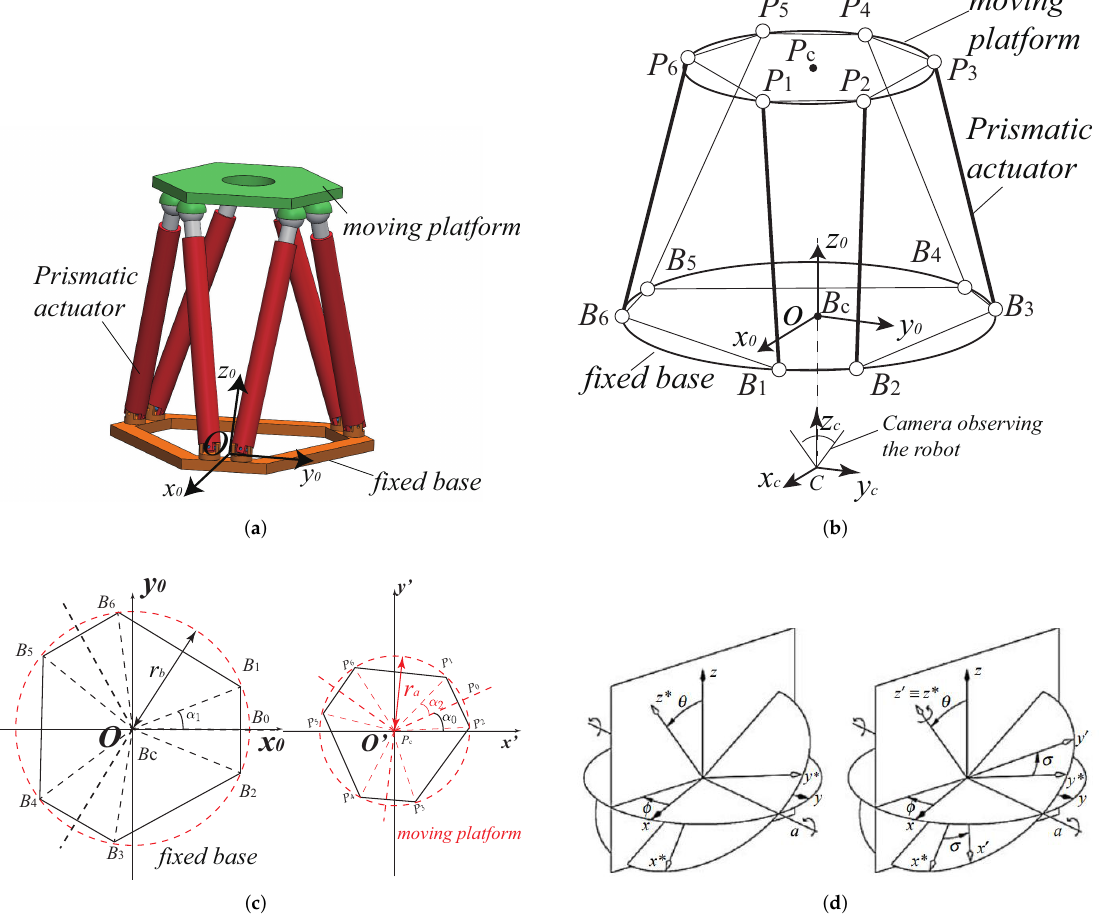
Figure 1. Schematics of the Gough–Stewart platform. ( a ) CAD of the Gough–Stewart platform with its regular dexterous workspace; ( b ) Schematics of the Gough–Stewart platform architecture; ( c ) Gough–Stewart platform geometric design parameters; ( d ) Tilt and torsion